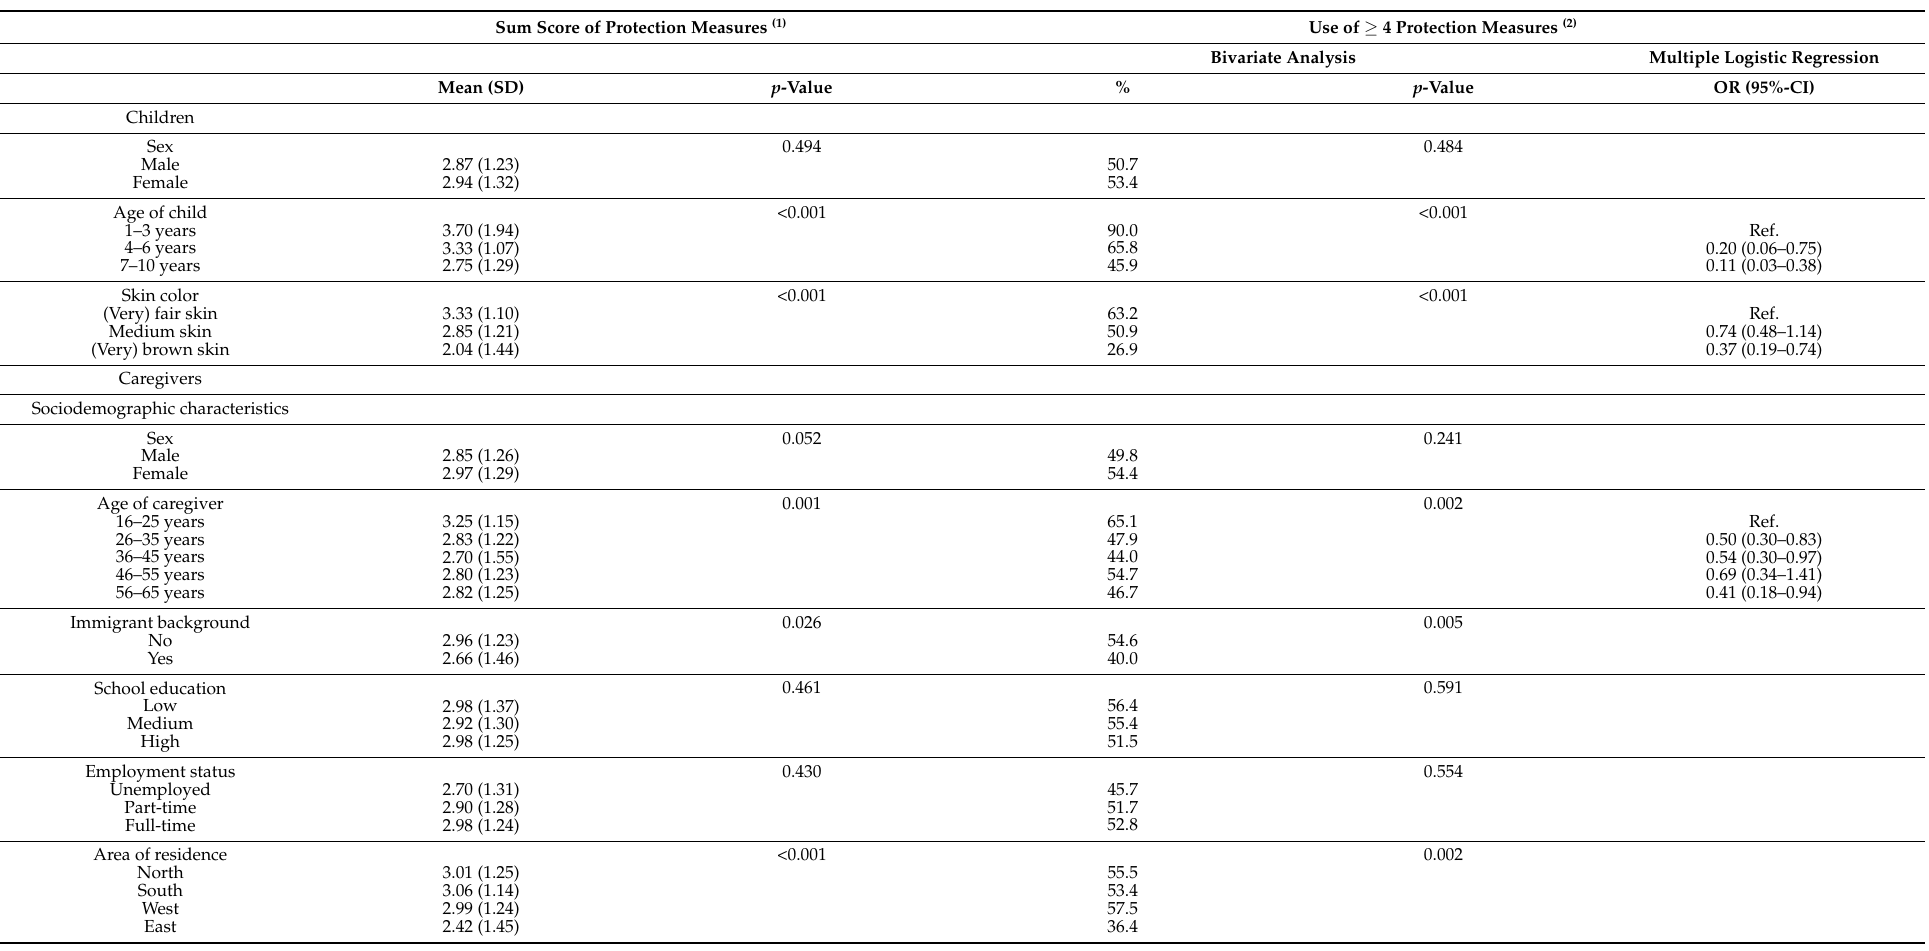
Table 4. Bivariate analyses and logistic regression on overall sun protection in children based on answers of 554 participants in wave 2020 of the National Cancer Aid Monitoring